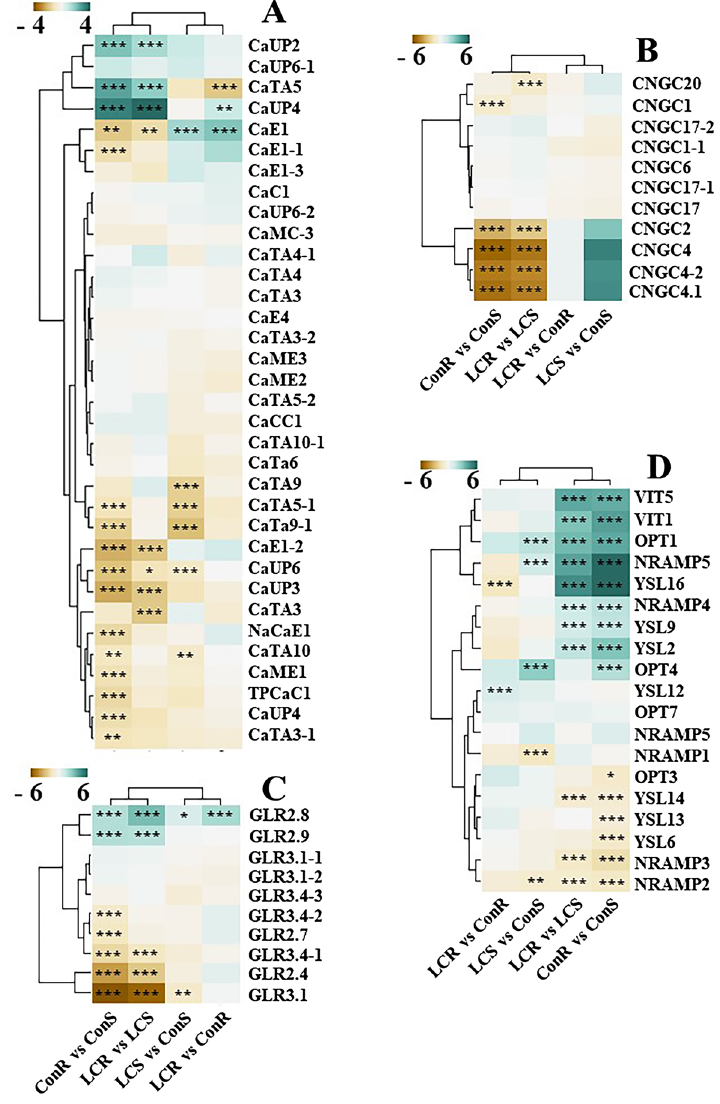
Figure 5. Heatmaps of differentially expressed genes. ( A ) Calcium transporters, ( B ) CNGCs, ( C ) GLRs and ( D ) Fe/metal transporters. Fe, iron, GLR, glutamate receptor; CNGC, cyclic nucleotide-gated channel, OPT, oligopeptide transporter; VIT, vacuolar iron transporter; NRAMP, metal transporter Nramp; YSL, yellow stripe-like; CaC1, calcium load-activated calcium channel; CaCC1, calcium permeable stress-gated cation channel 1; CaUP, calcium uniporter protein; CaMC,